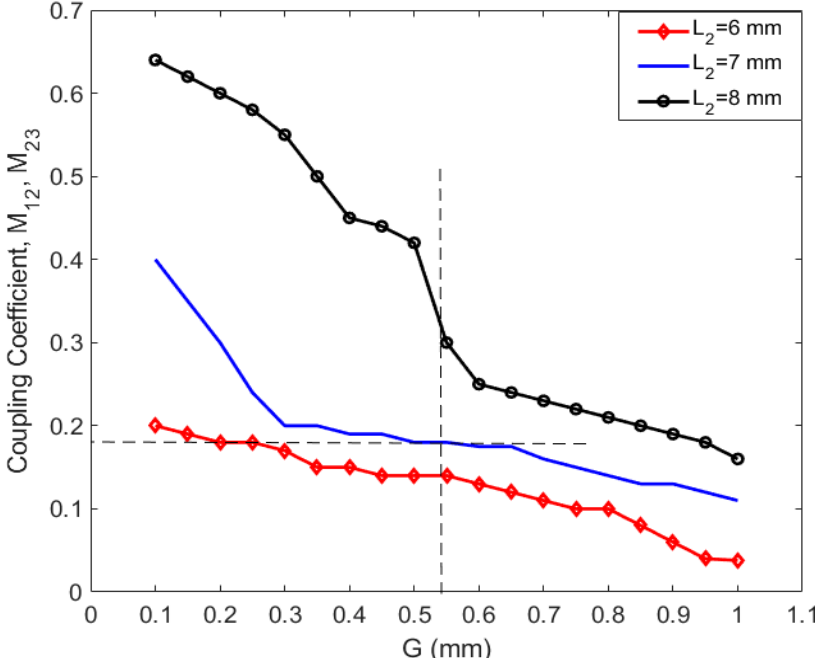
Figure 4. Theoretically calculated coupling coefficient performance of the presented three-pole planar BPF.